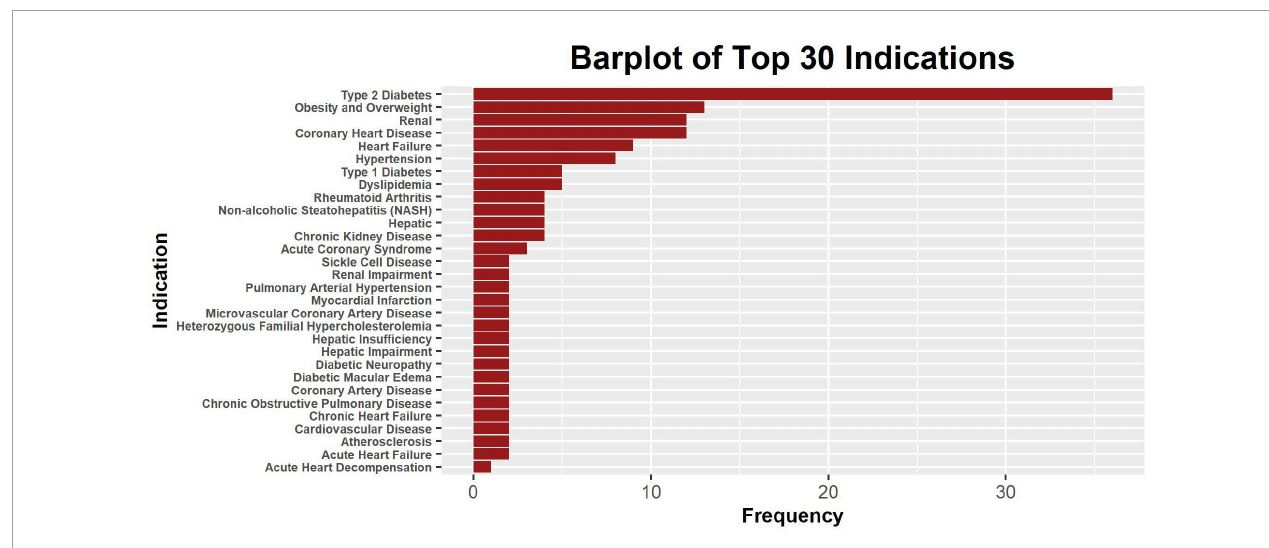
FIGURE2 The bar plot of 30 most frequent clinical indications. Only a part of the indications is shown, and some drugs may have multiple indications. The level of specificity of indications varies across drugs, and some indication counts were intended to be redundant to account for differences in